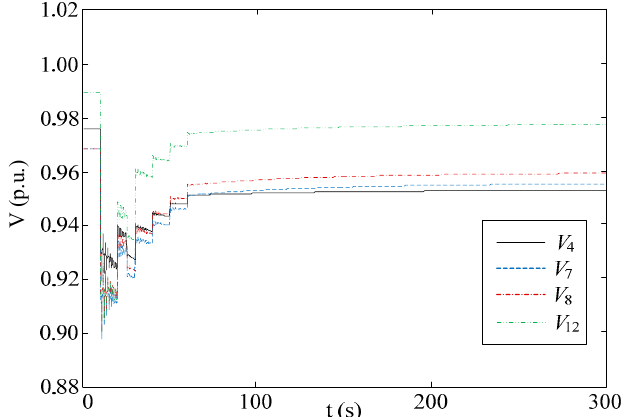
Figure 15. Voltage evolution using AH-MPC with both disturbance and model mismatch occurred during the control process.